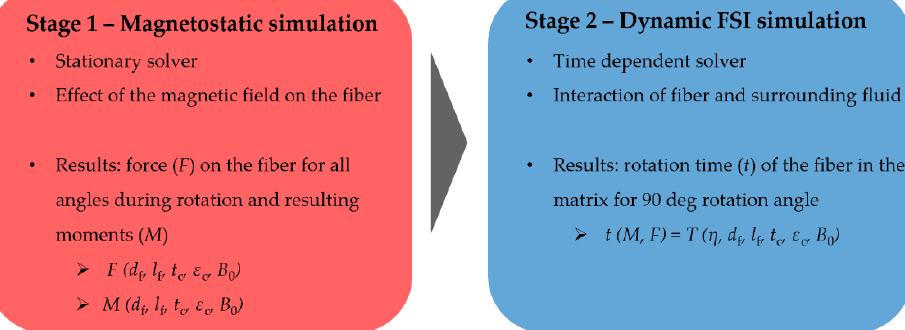
Figure 3. Developed simulation procedure divided into two stages for the representation of the induction of a force caused by an external magnetic field to the fiber (stage 1) and the interaction of the fiber and surrounding fluid during the orientation process (stage 2).